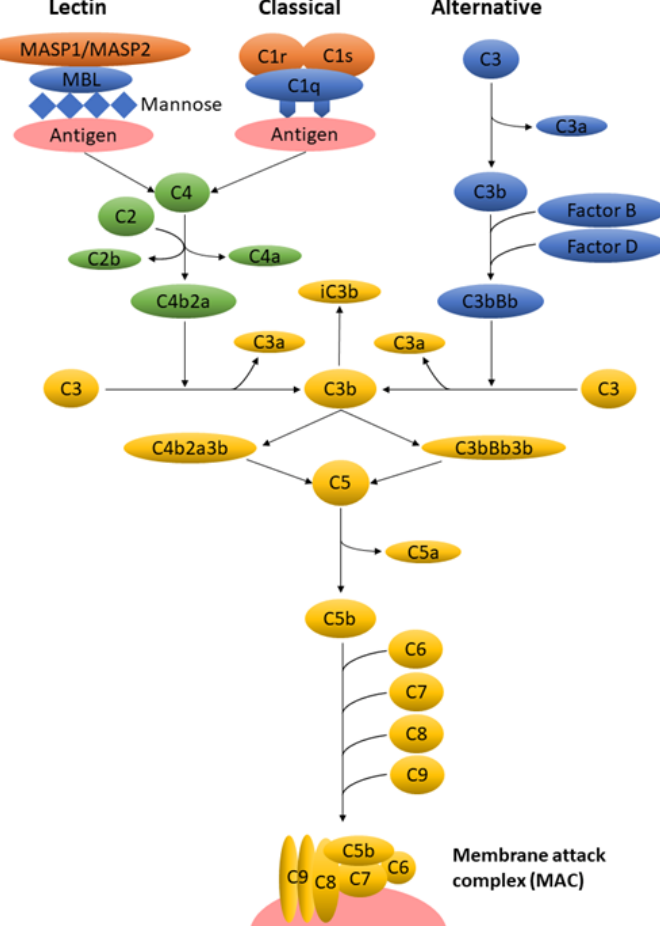
Figure 1. A simplified overview of different activation pathways of the complement system. There are three complement activation pathways: the classical pathway, which is activated by antibody binding or the direct fixation of complement component C1q bound to zymogens C1r and C1s on the surface of an antigen; the lectin pathway, which is triggered by the binding of mannan-binding lectin (MBL) activated by MBL-associated serine proteases (MASP), namely MASP1 and MASP2, to mannose contained on the surface of an antigen; and the alternative pathway, which is triggered directly by the binding of spontaneously activated complement component on the surface of an antigen. The complement enzymatic cascades of each pathway generate a key protease called C3 convertase that cleaves C3 into C3b and C3a. This complement activation leads to eventual antigen opsonization, inflammatory responses, and membrane lysis.